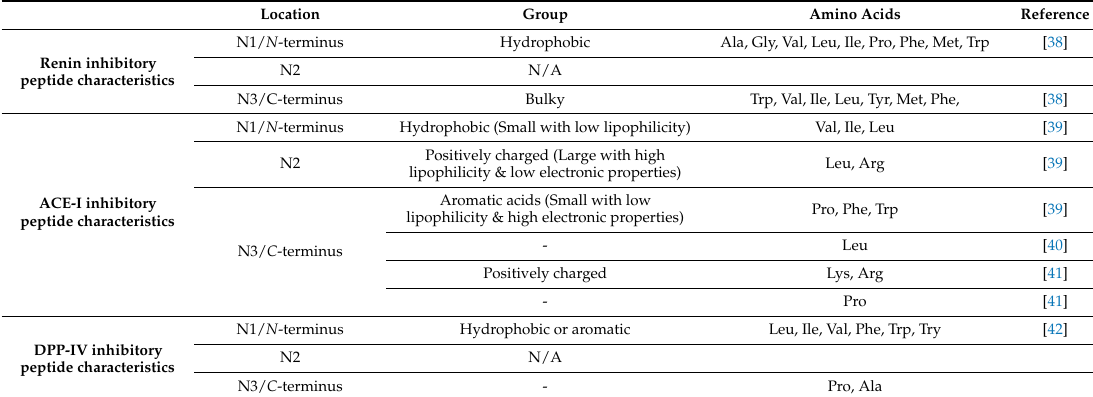
Table 2. Characteristic criteria used to identify tripeptides with predicted renin, angiotensin-I-converting